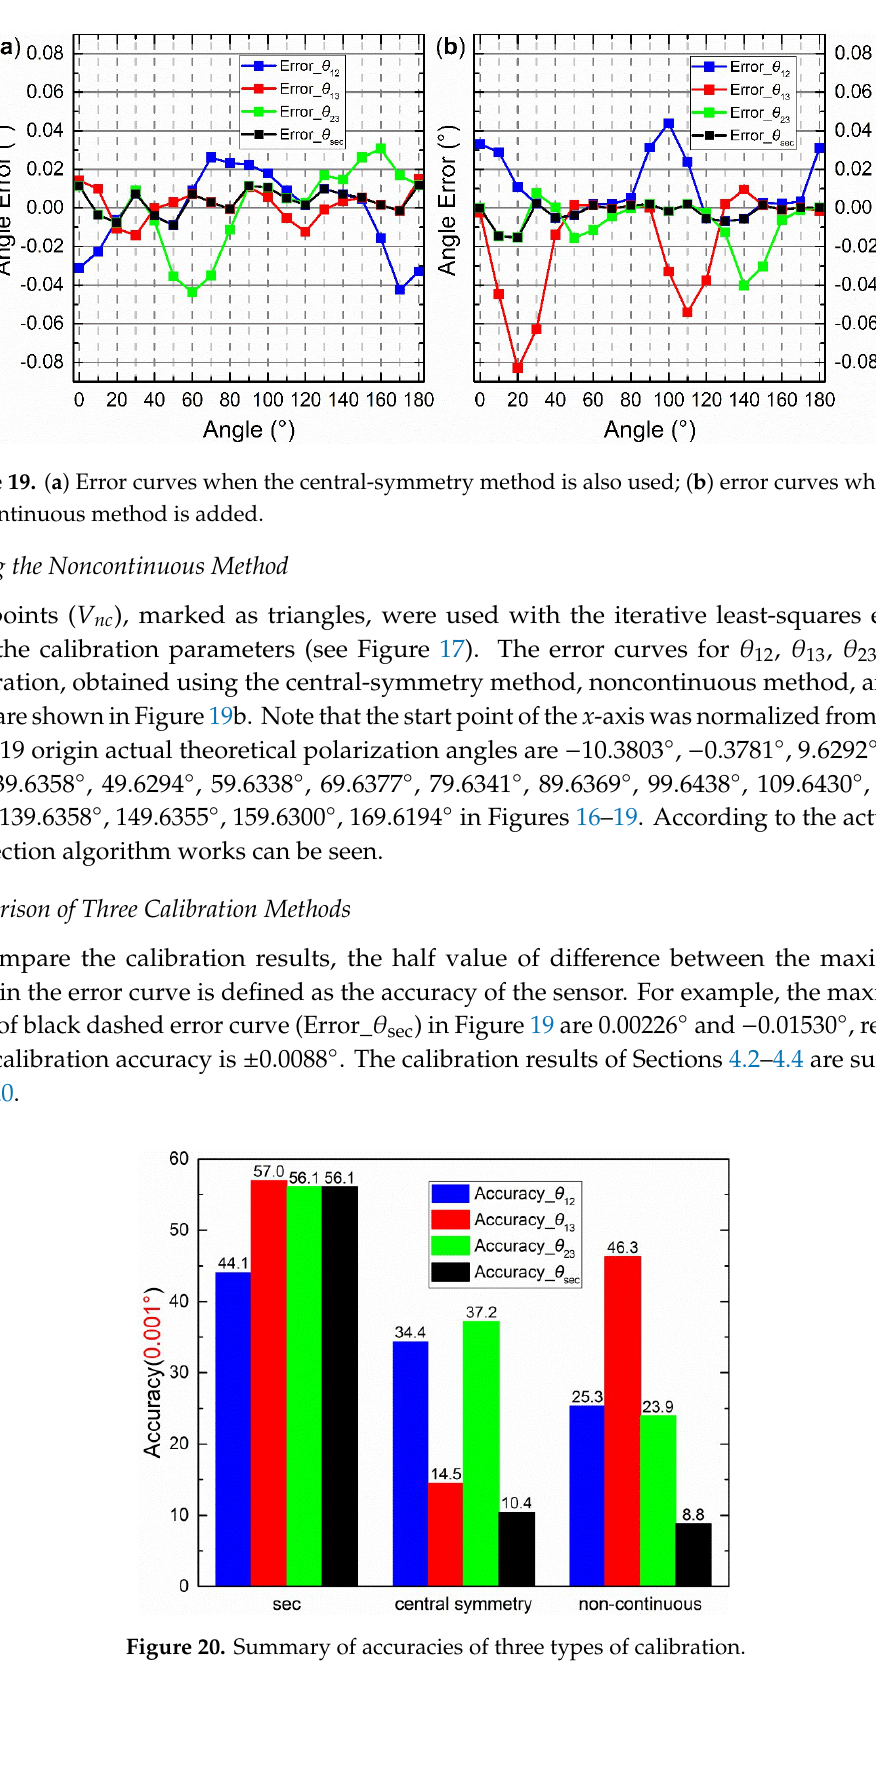
Figure 18. Experimental data analysis when the central-symmetry method is also used.